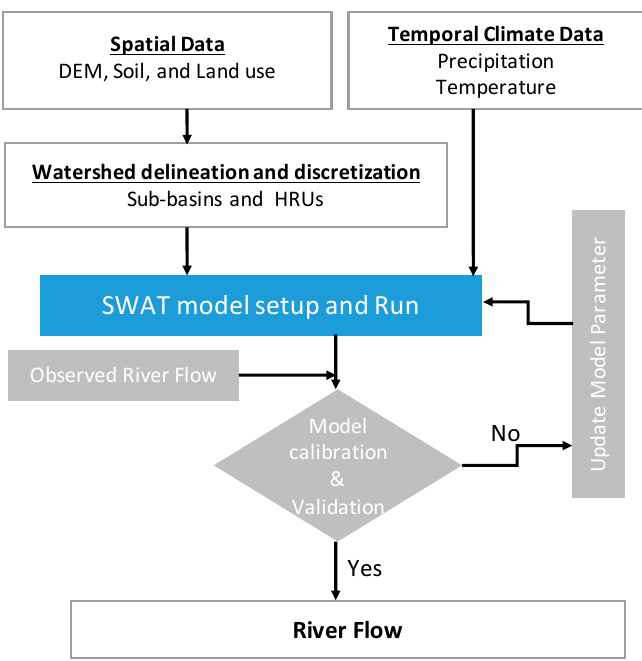
Figure 3. Methodological framework for application of SWAT hydrological model.